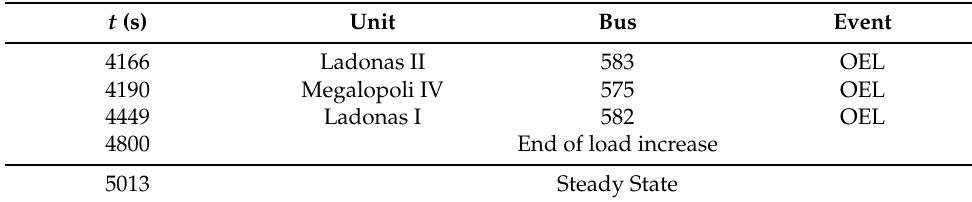
Table 3. Sequence of events in stable scenario, after 4090s.